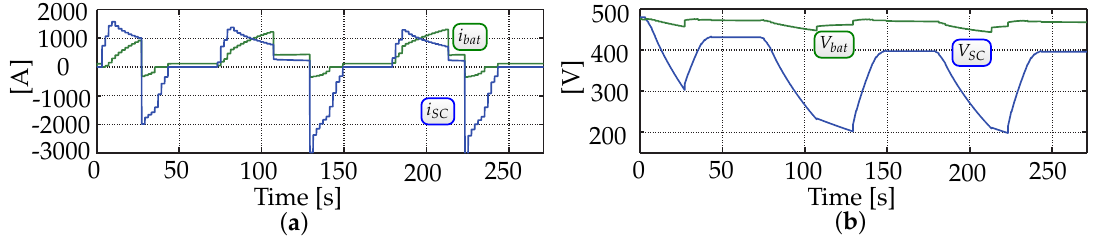
Figure 7. Simulation results for MPC based two-objectives cost function optimization energy management systems (EMS) with three typical stops in the driving cycle of the LR: ( a ) battery current and SC current and ( b ) battery voltage and SC voltage.